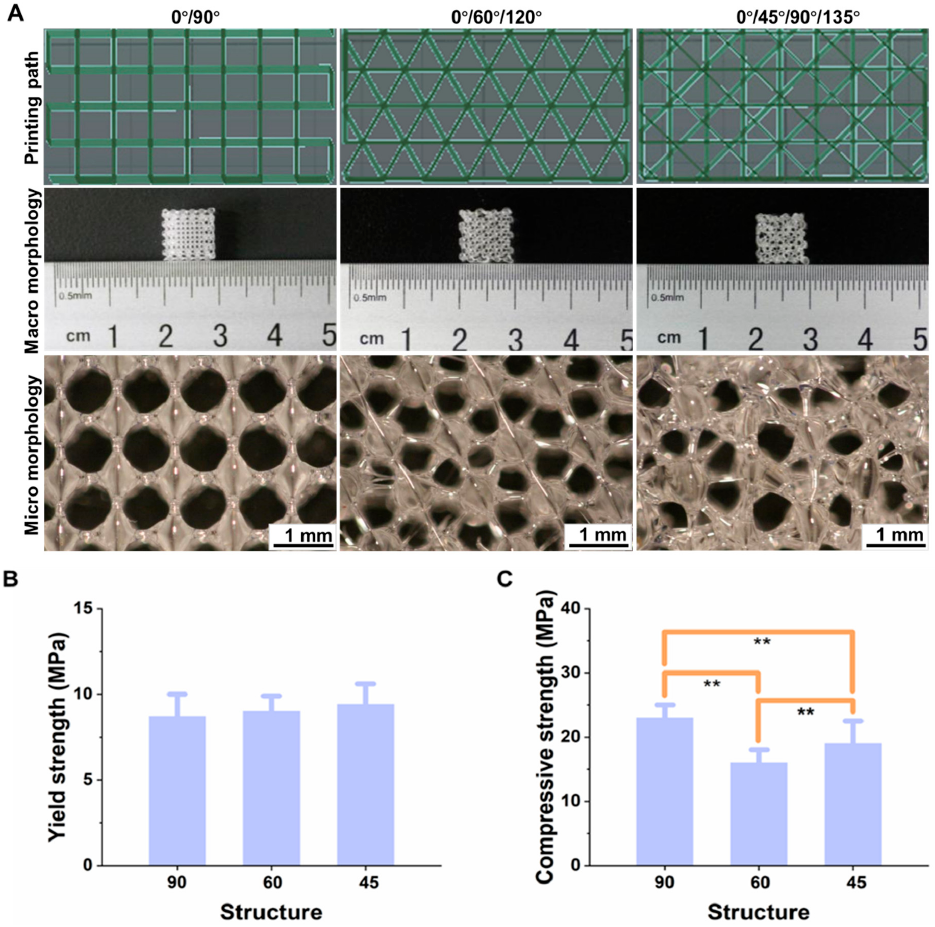
Figure 1. ( A ) Printing path, macro—as well as micro—morphology of the PLGA scaffolds. Change of ( B ) yield stress, and ( C ) compressive strength, at various printing angles. The size of the scaffolds was 10 mm × 10 mm × 4 mm, with an area of error of about ±0.05 cm 2 , ( n = 5). ** represents p < 0.01. Table 2. Pore size and a wire diameter of the scaffolds, printed at three different angles. Structures